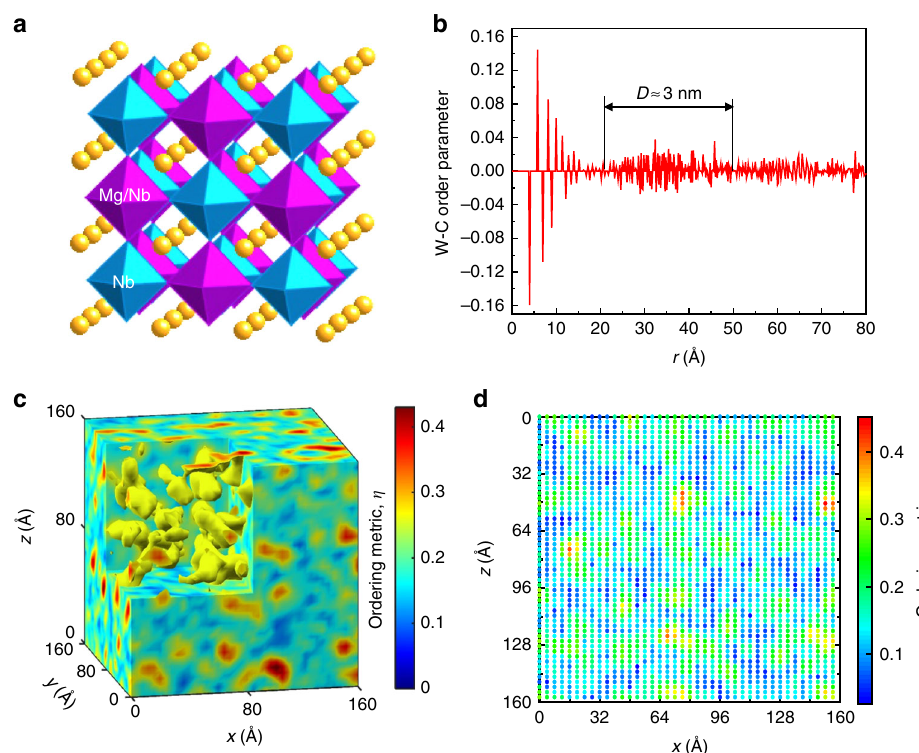
Fig. 2 Characteristics of the chemical ordering of Mg and Nb. a A schematic rendering of the rocksalt-type partial ordering of Nb and Mg, with the alternate {111} planes occupied by Nb (blue octahedra) and the Mg 2/3 Nb 1/3 (magenta octahedra) mixture, respectively. The Pb atoms are represented using yellow spheres. b The Warren – Cowley (W-C) short-range order parameter 30 for the distribution of Mg and Nb, calculated as a function of interatomic distance for the re fi ned con fi guration. A characteristic length, D , that corresponds to the effective size of chemically ordered regions is indicated. c A 3D distribution of the local chemical short-range order parameter, η (see the Methods section), which varies continuously across the regions of enhanced order. d A 2D map of the local order parameter calculated from the projected Z -map (see text) for the re fi ned con fi guration as described in ref. 27 . The x and z axes correspond to the [001] and [110] directions, respectively. This map agrees well with its analog derived from the experimental scanning transmission electron microscopy images